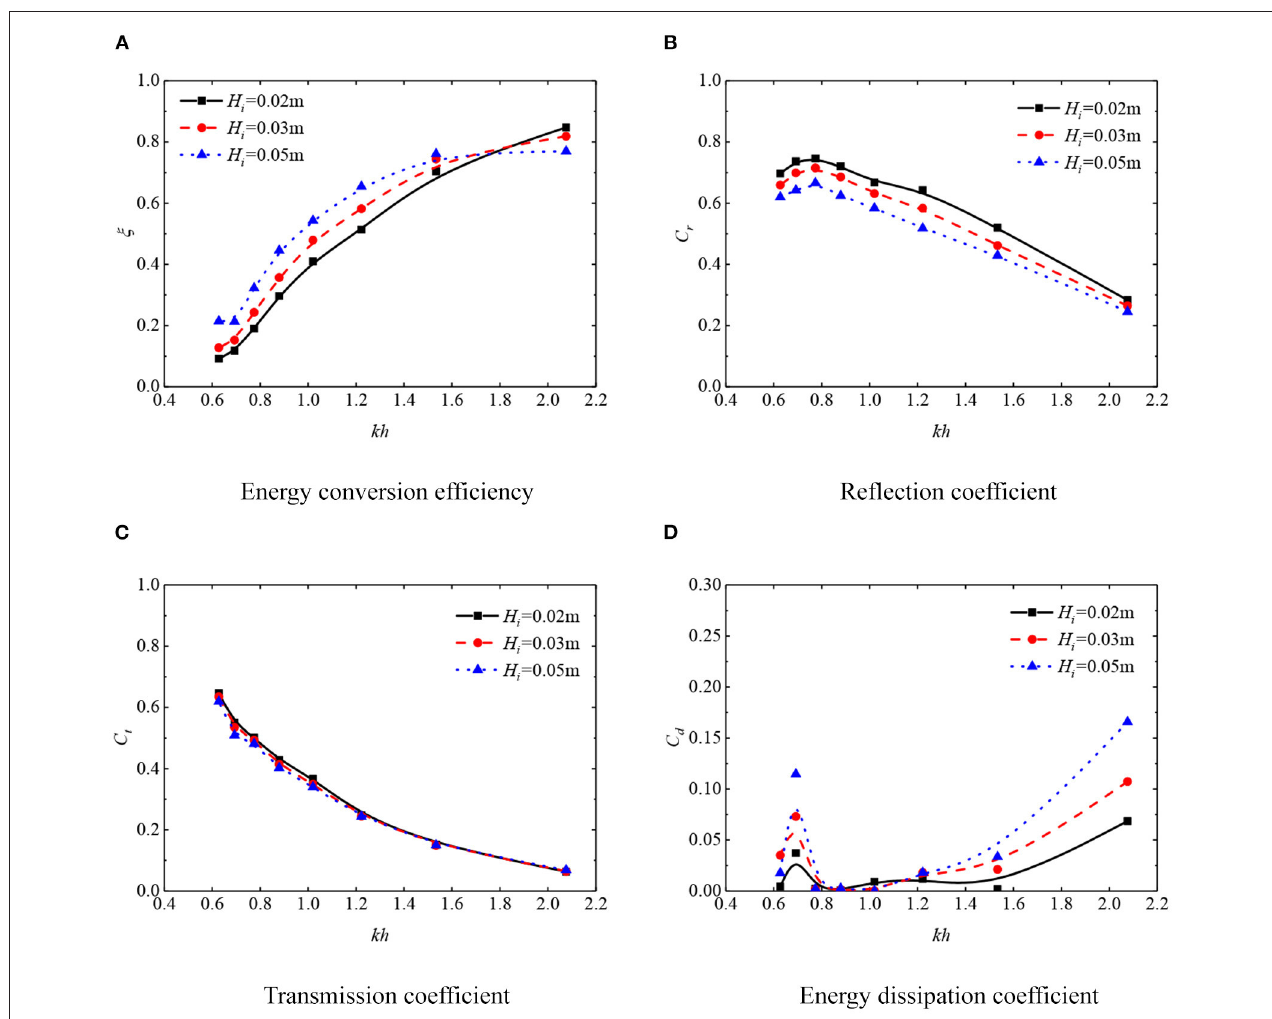
FIGURE 9 | Hydrodynamic coefficients of OWC devices with three incident wave heights for d 2 = 7.5 d 1 , B = 2.5 a . (A) Energy conversion efficiency. (B) Reflection coefficient. (C) Transmission coefficient. (D) Energy dissipation